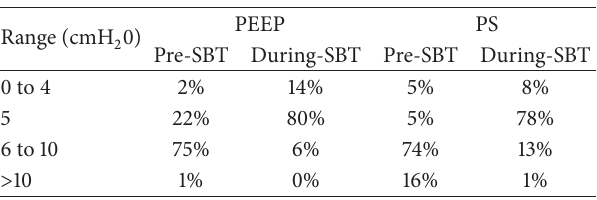
Table 1: Overall distribution of PEEP and PS ranges amongst all SBTs. Ranges shown for pre- and during-SBT